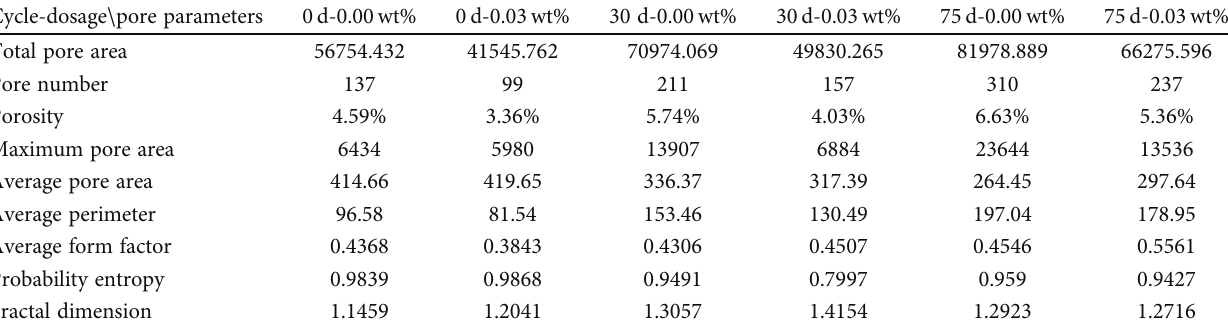
Table 4: Pore structure parameter values.